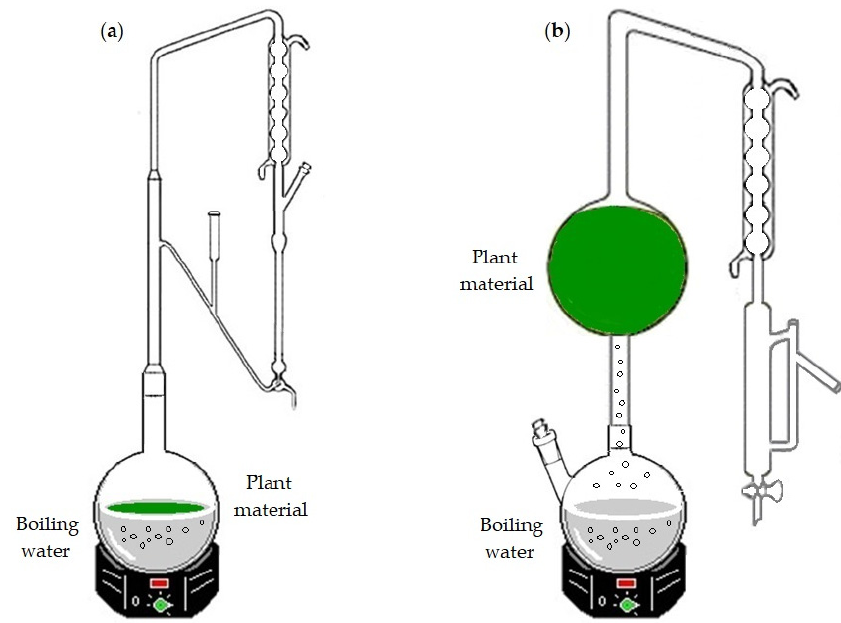
Figure 1. Apparatus for ( a ) hydrodistillation (HD) and ( b ) water-steam distillation (WSD) processes. In the HD, the plant material is submerged in the boiling water, while in the WSD, it is packed above the steam source (boiling